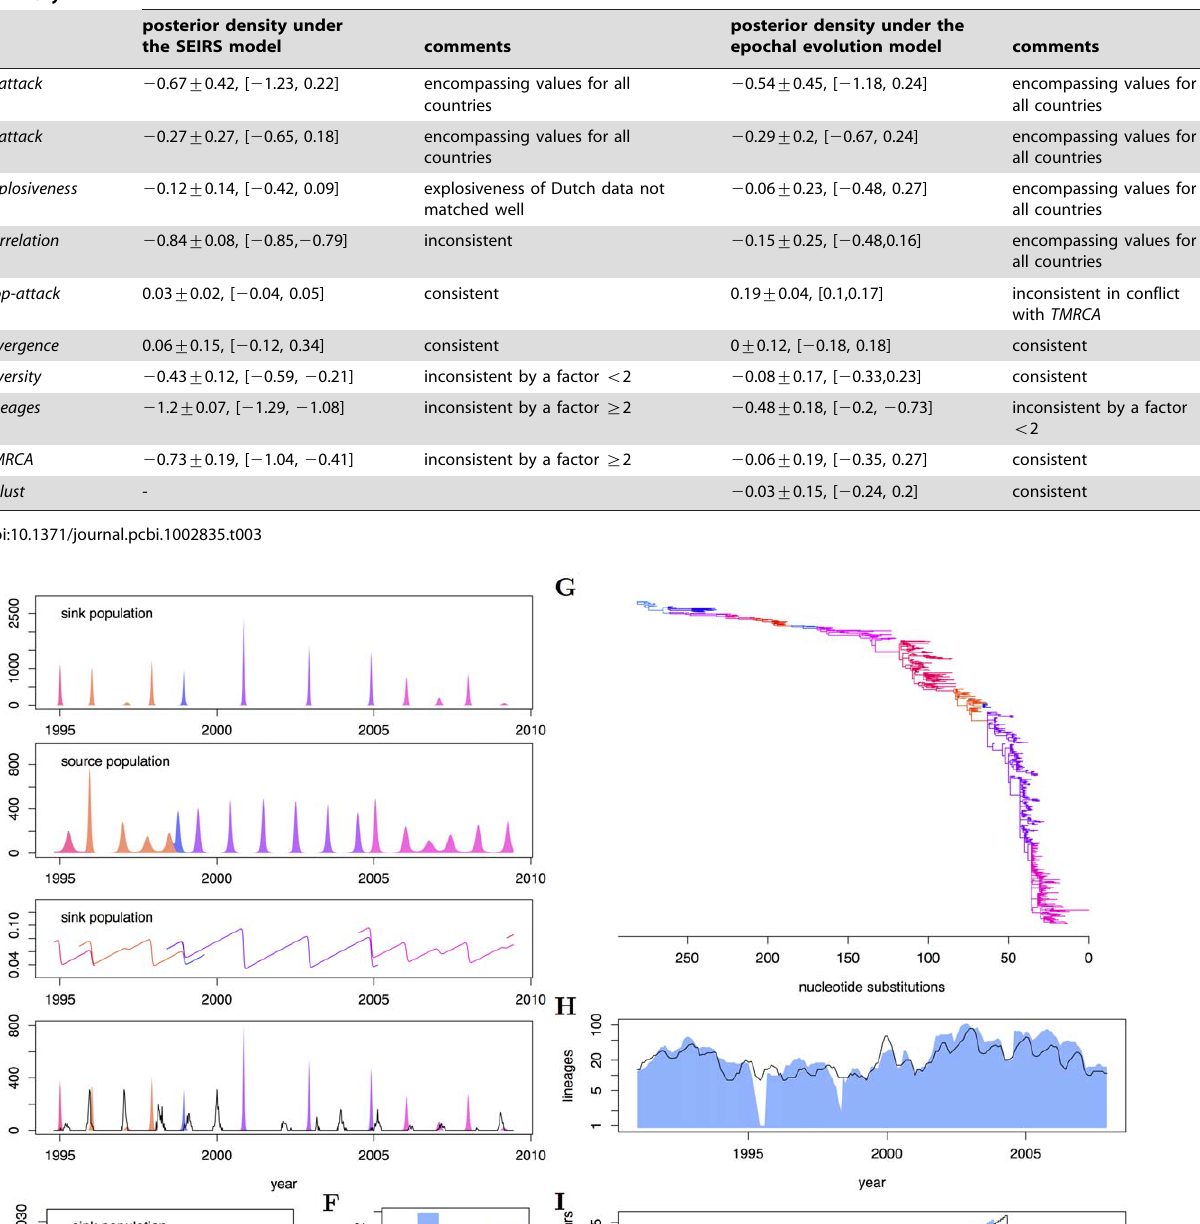
Table 3. Goodness of fit to summaries of H3N2 surveillance data and phylogenies.